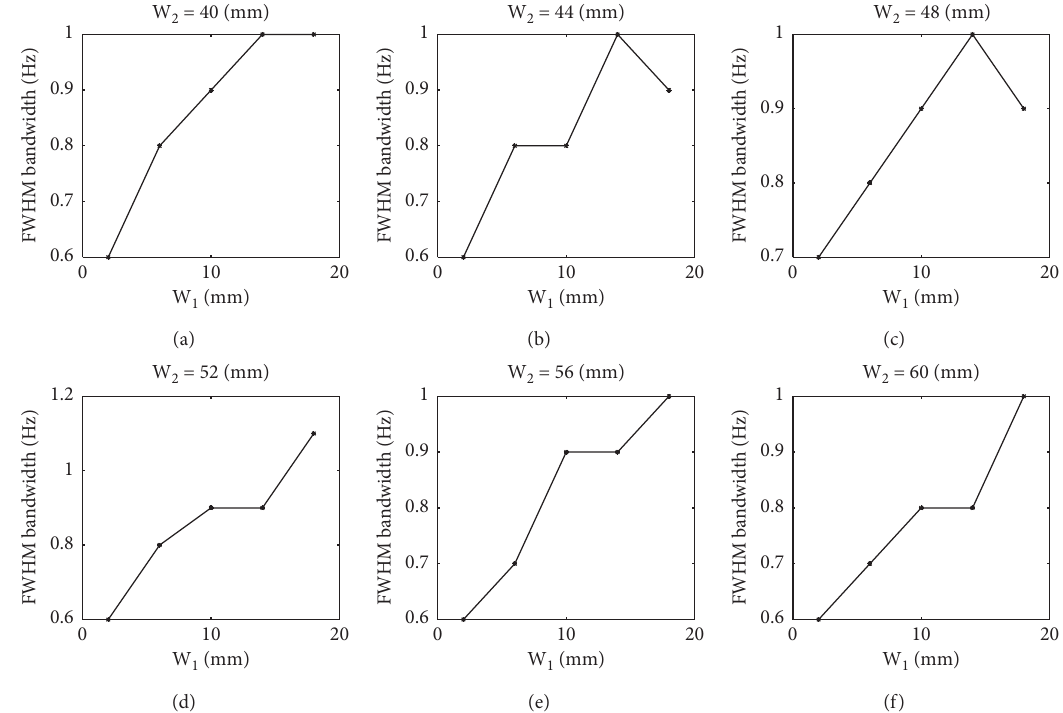
Figure 14: Real electrical power density FWHM bandwidth of 30 various geometries of the trapezoidal composite piezoelectric bimorph beam (second design) in a closed circuit with an optimal resistor load fixed. The length of the beam L is 60mm, the thickness of T piezo is 0.3mm, and the thickness of the brass layer T s is